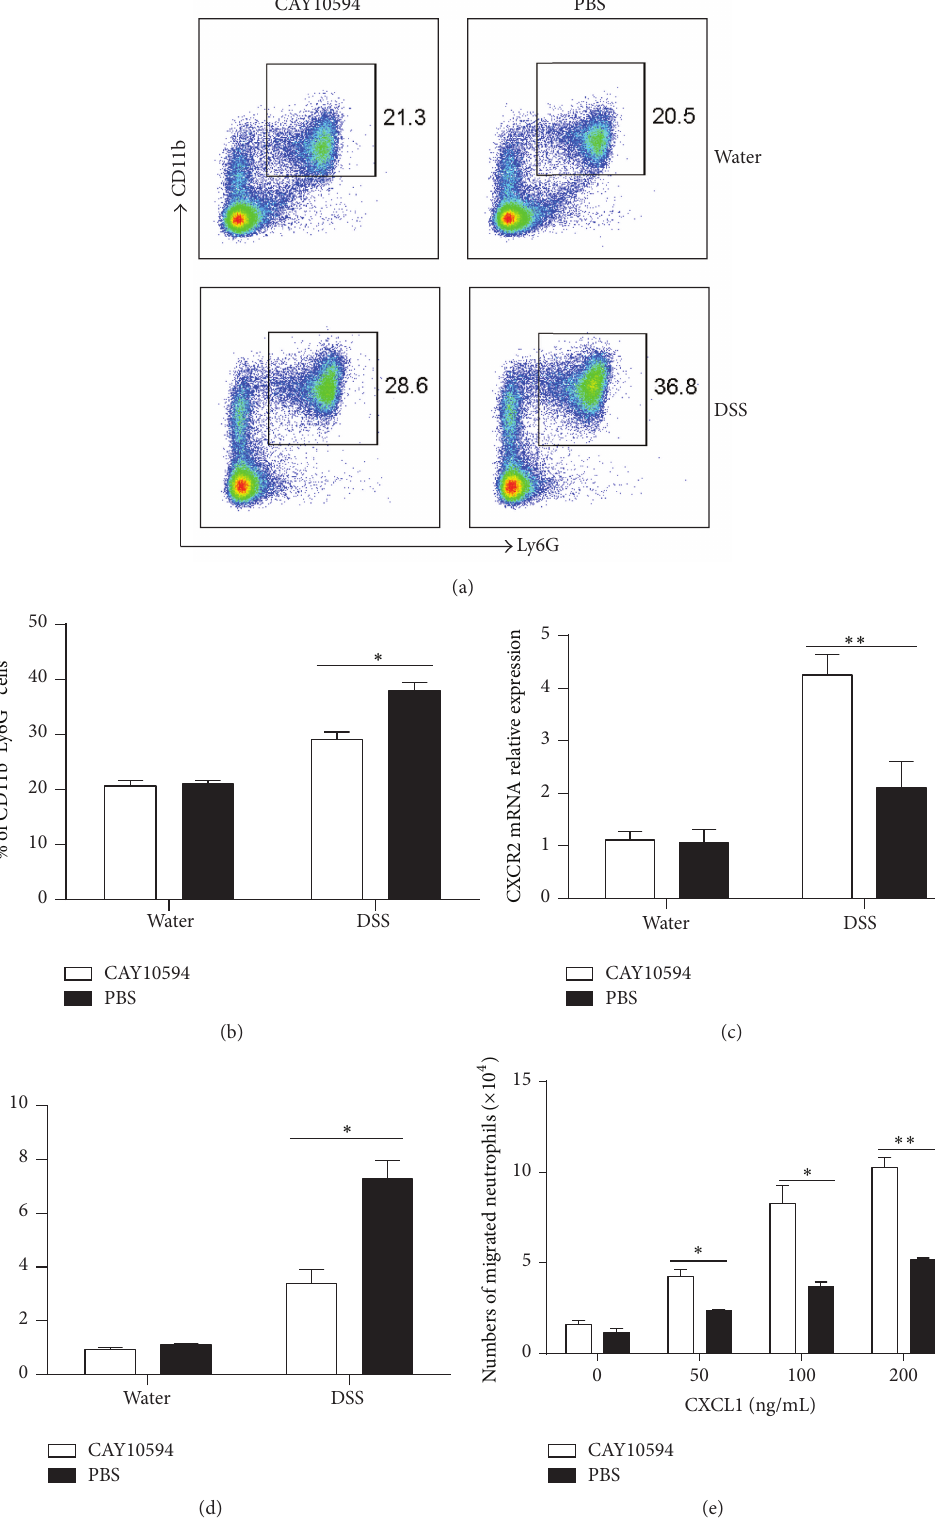
Figure 7: Inhibition of PLD2 promotes neutrophil migration. (a) Bone marrow cells were isolated from DSS-induced mice on day 10, and expression of Ly6G and CD11b was analyzed by flow cytometry. (b) Percentages of Ly6G + CD11b + neutrophils were calculated. ∗ 𝑝 < 0.05 and ∗∗ 𝑝 < 0.01 versus controls. ((c) and (d)) Neutrophils were isolated from the bone marrow of mice; expression of CXCR2 (c) and GRK2 (d) was examined by qRT-PCR. ∗ 𝑝 < 0.05 and ∗∗ 𝑝 < 0.01 versus controls. (e) Neutrophils were isolated from the bone marrow of mice on day 10 after DSS-induced colitis and stimulated in vitro with PLD2 inhibitor (CAY10594, 10 𝜇 m) for 30 min; neutrophil migration was then analyzed by a Transwell plate (5 𝜇 m) under the stimulation with CXCL1 (0, 50, 100, 200 ng/mL) for 30 min. ∗ 𝑝 < 0.05 and ∗∗ 𝑝 < 0.01 versus